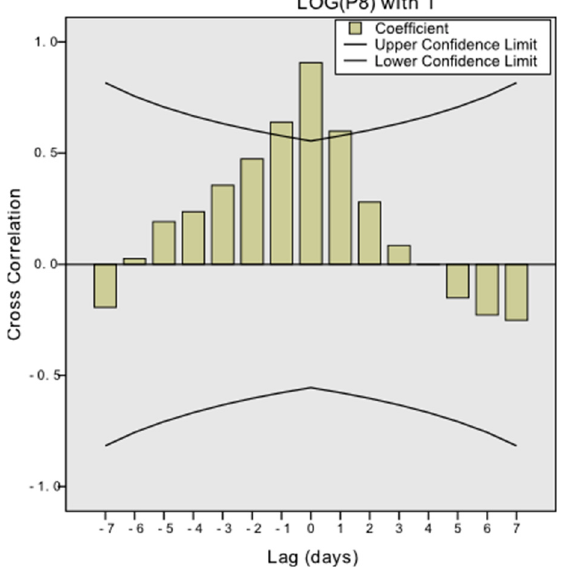
Figure 7. The estimates of the cross-correlation coefficients r for lags k = 0; ± 1; . . . ; ± 7, between daily values of the logarithm of the P8 proton flux values and the temperature T M from day 6 until day 16, March 2015. The solid black lines present the asymptotic 95% confidence limits of the estimated coefficients. The very large r value at lag = 0 confirms and explains the good resemblance of P8 and T M curves seen in Figure 8 (adapted from Figure 2 of [8]) .